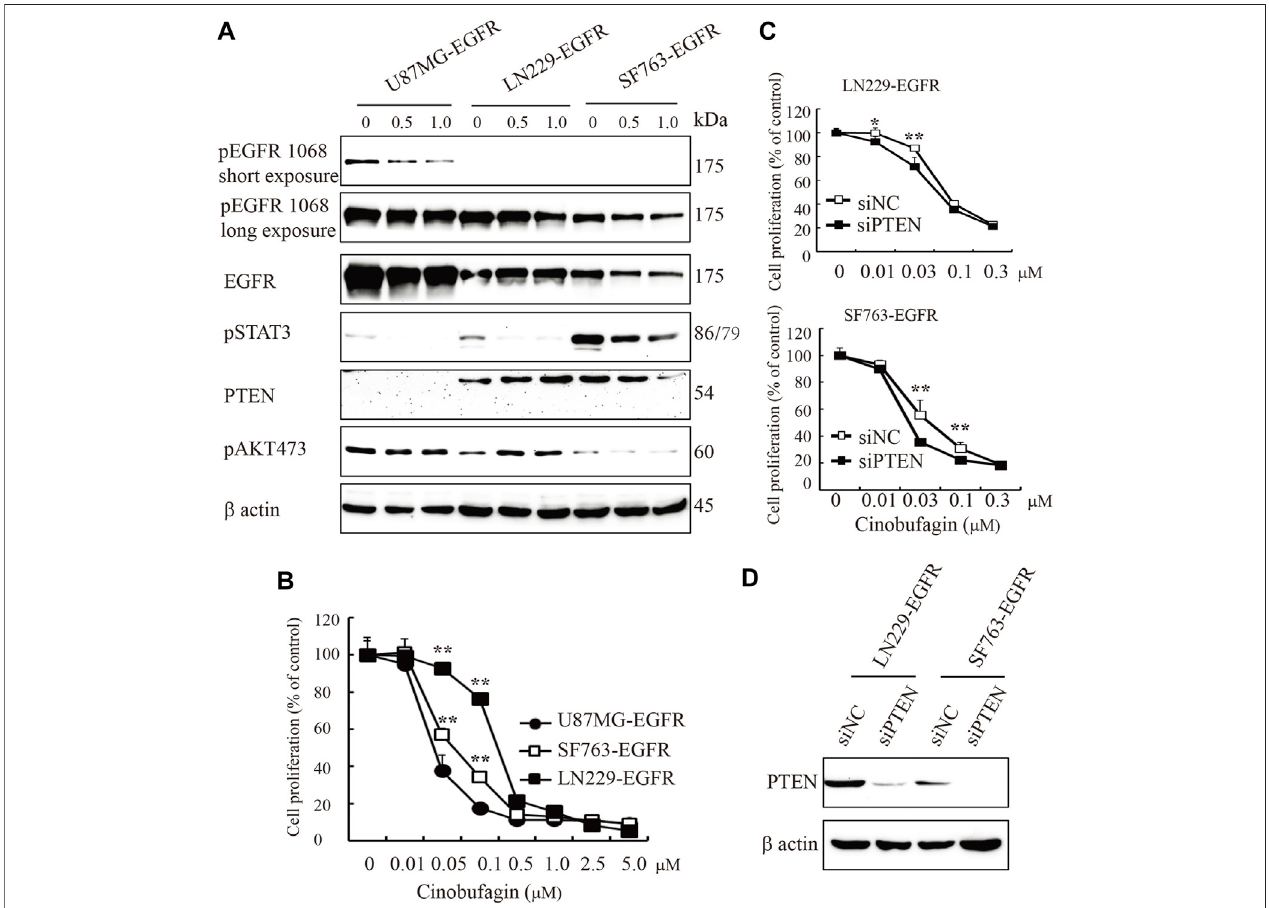
FIGURE 4 | PTEN de fi ciency enhances cinobufagin ’ s antiproliferation effect. (A) PTEN, EGFR expression, and its downstream signaling molecules analyzed by Western blot. U87MG-EGFR, LN229-EGFR, and SF763-EGFR cells were treated with cinobufagin for 6 h, followed by Western blot analysis of PTEN, EGRR, and its downstreammolecules. (B) Cinobufaginmoreef fi cientlyinhibits cellproliferationofglioblastomacelllineswithEGFRoverexpression andPTENde fi ciency.Glioblastoma cellsweretreatedwitharangeofdosesofcinobufaginfor72 h,thenfollowedbyCCK8assay. (C) ProliferationofLN229-EGFRandSF763-EGFRcellstransfected with control or PTEN siRNA for up to 4 days, followed by CCK8 assay. (D) Western blot checks the PTEN expression. Data are means ± SD.